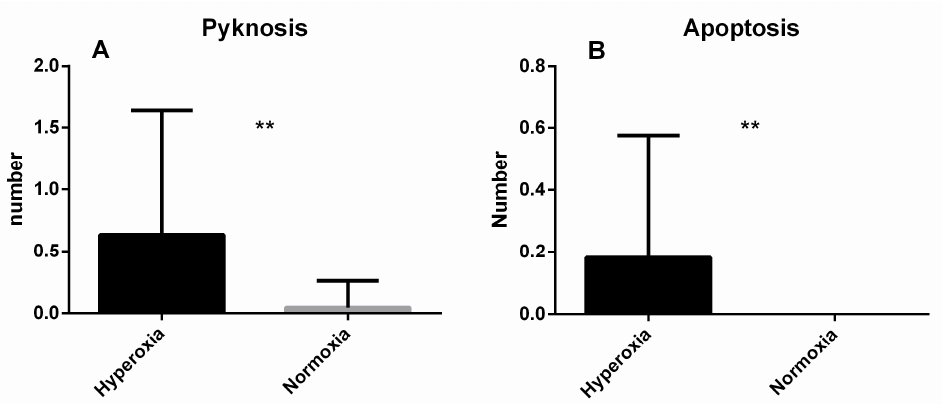
Figure 8. Comparison between the number of pyknotic nuclei ( A ) and apoptotic cells ( B ) in a JURKAT cell line population between the hyperoxia and normoxia groups, as assessed by microscopic analysis ( p = 0.006). Data are expressed as mean ± SEM.